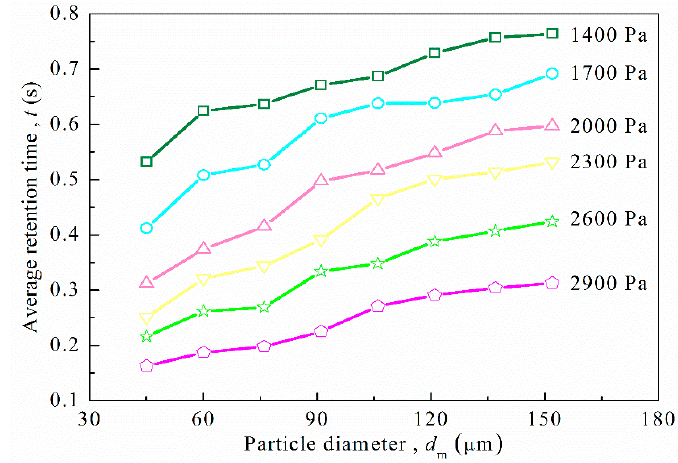
Figure 11. Influence of pressure drop on the average retention time.